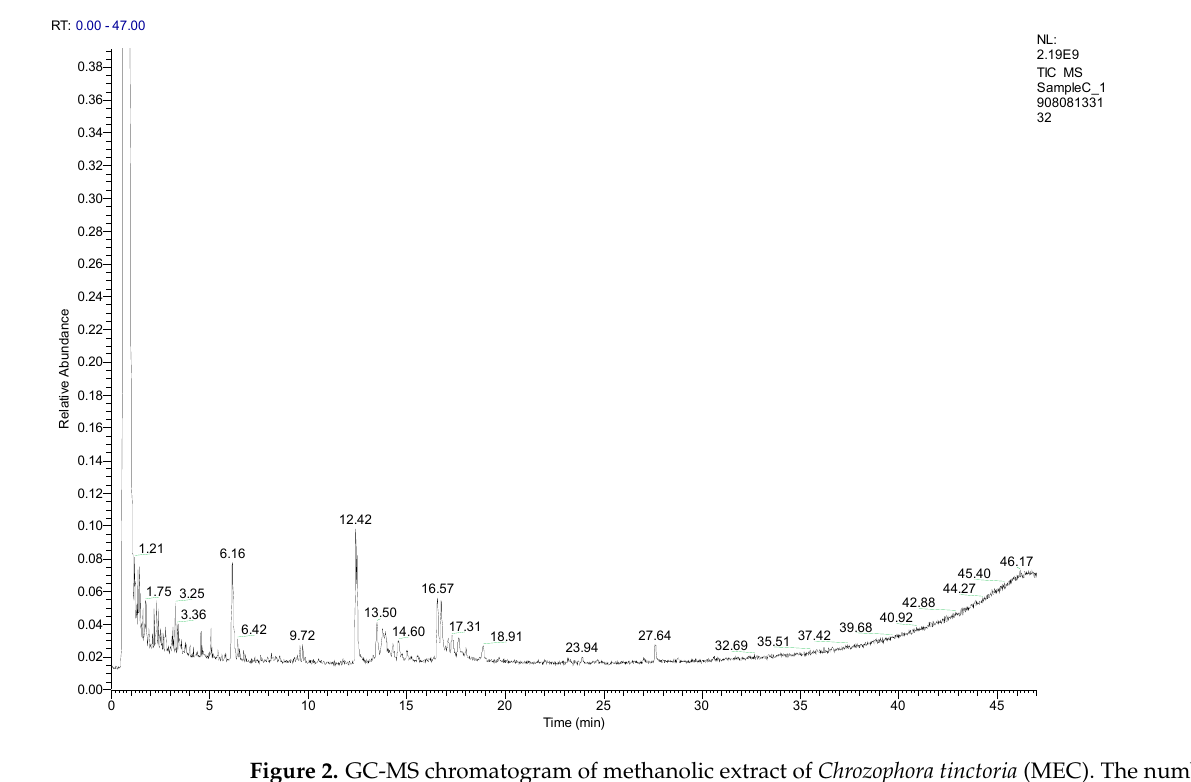
Figure 2. GC-MS chromatogram of methanolic extract of Chrozophora tinctoria (MEC). The numbers in the chromatogram are the retention times of the compounds. Table 1. Bioactive compounds identified in methanolic extract of Chrozophora tinctoria by GC-MS.